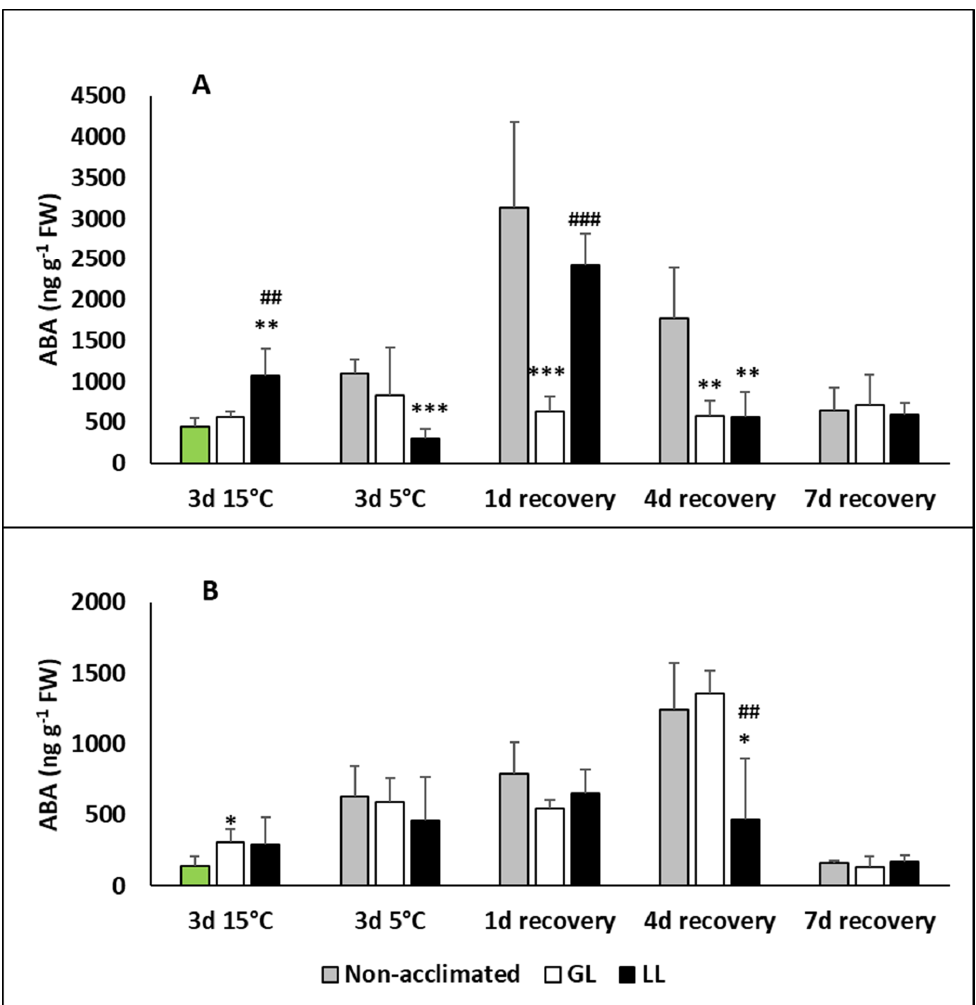
Figure 3. Changes in the abscisic acid (ABA) contents during cold acclimation (15/13 °C), chilling (5 °C) and recovery in the leaves and roots of young maize plans: control plants (22/20 °C, 387 µmol m −2 s −1 ). Light intensities during hardening: GL: 387 µmol m −2 s −1 ; LL: 107 µmol m −2 s −1 . *, **, *** significant differences compared to the control plants on the same day at the p < 0.05, 0.01 and 0.001 levels, respectively. ## , ### significant differences compared to the GL plants on the same day at the p < 0.05 and 0.001 levels, respectively. ( A : free ABA in the leaves; B : free ABA in the roots). The jasmonic acid (JA) level did not change in the leaves during acclimation, but chilling significantly increased it in the cold-acclimated GL plants and especially in the non-acclimated ones (Figure 4A). On the first day of recovery, the JA level dropped back to the initial level only in the acclimated plants, but from the fourth day its level was sometimes even less than before the acclimation period. No effect of the light could be observed on the amount of JA during the acclimation, chilling and recovery periods. On the contrary, a slight elevation could be seen in the roots acclimated under GL conditions, but no changes in the LL plants (Figure 4B). The JA level in the roots increased during the chilling in non-acclimated plants, and more pronouncedly in GL, while no changes could be seen in LL plants. Interestingly, some rise could be observed in non-acclimated and LL plants on the first day of recovery, but a decrease in GL roots. On the seventh day of recovery, the JA level was similar to the initial one.